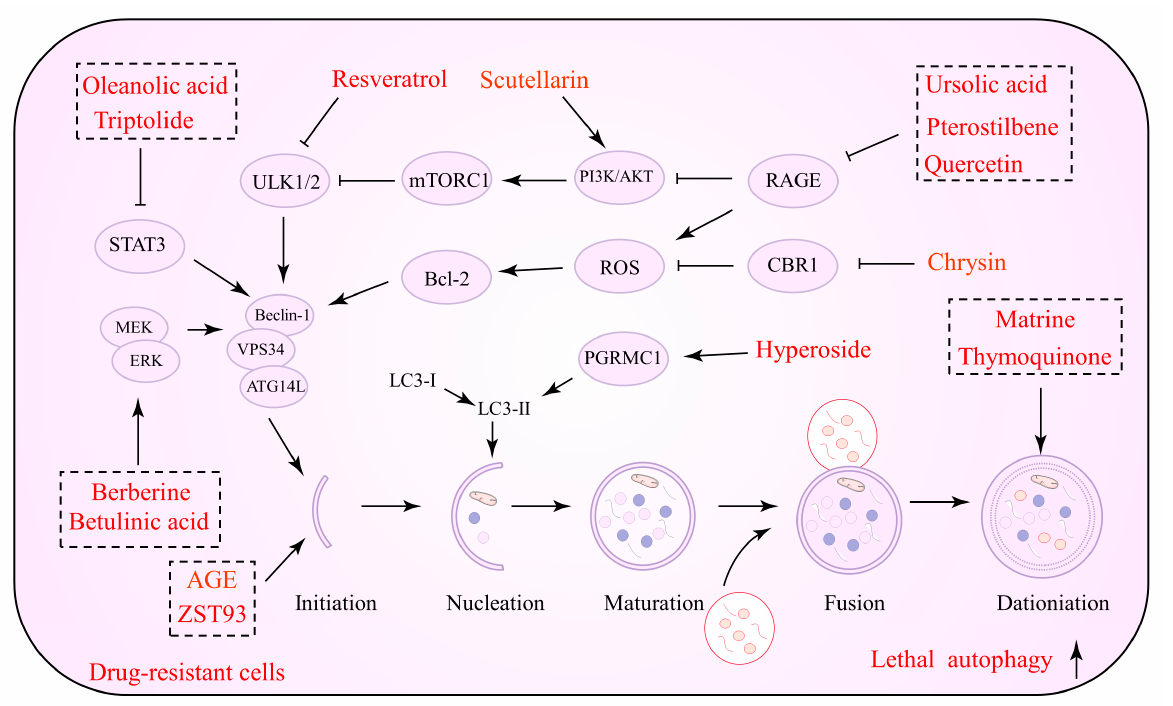
Figure 1. Natural products against tumor drug resistance by inhibiting pro-survival autophagy. Plant-derived terpenoids are another possible novel anti-cancer drug class. They reg- ulate cancer cell proliferation, migration, angiogenesis, and drug resistance [56]. Several drug resistance and enhance chemotherapeutic and synthetic drug sensitivity [57]. An-